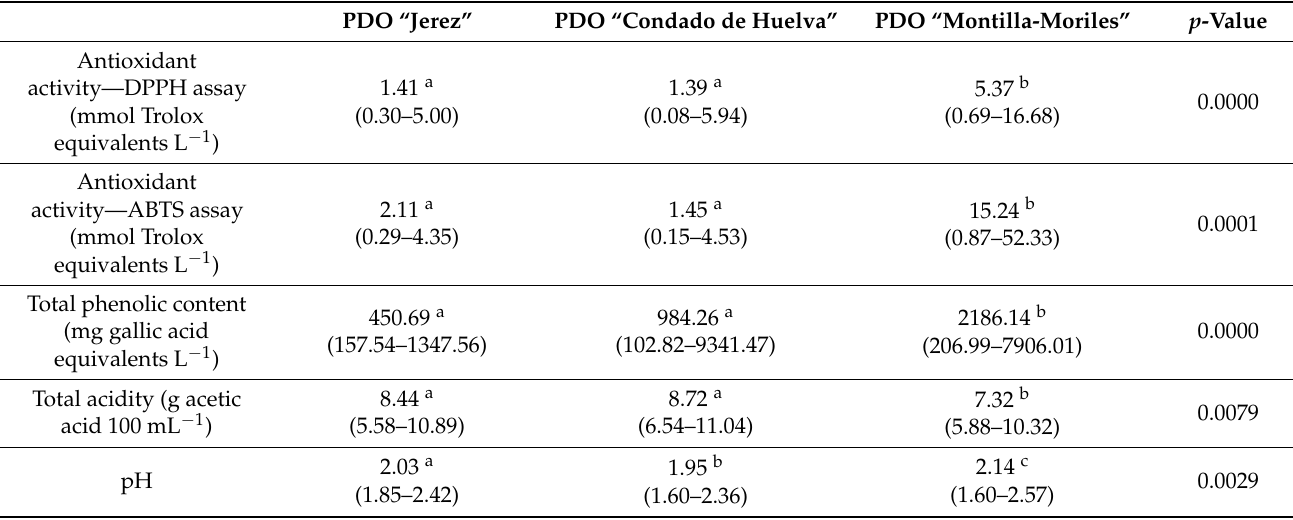
Table 1. Mean, minimum and maximum values for the antioxidant activity, total phenolic content, total acidity and pH in vinegar samples from the three Andalusian PDOs, and p -values obtained by ANOVA. PDO “Jerez” PDO “Condado de Huelva” PDO “Montilla-Moriles” p